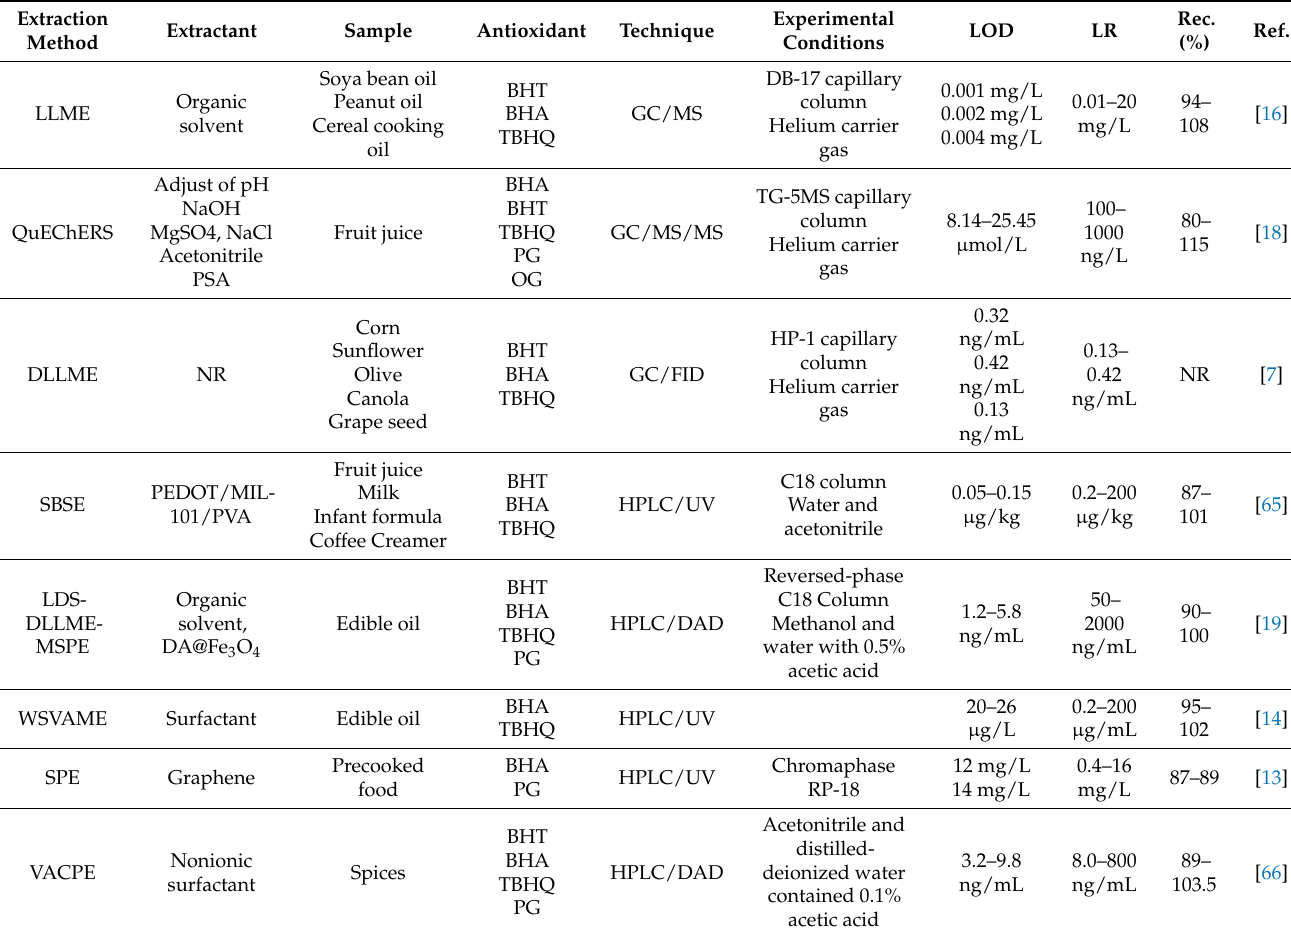
Table 2. Information about the synthetic phenolic antioxidant detection indicating the extraction method, extractant, type of sample, technique, experimental conditions, limits of detection, and recovery values. These pieces of information were obtained from scientific databases in the years 2011 to